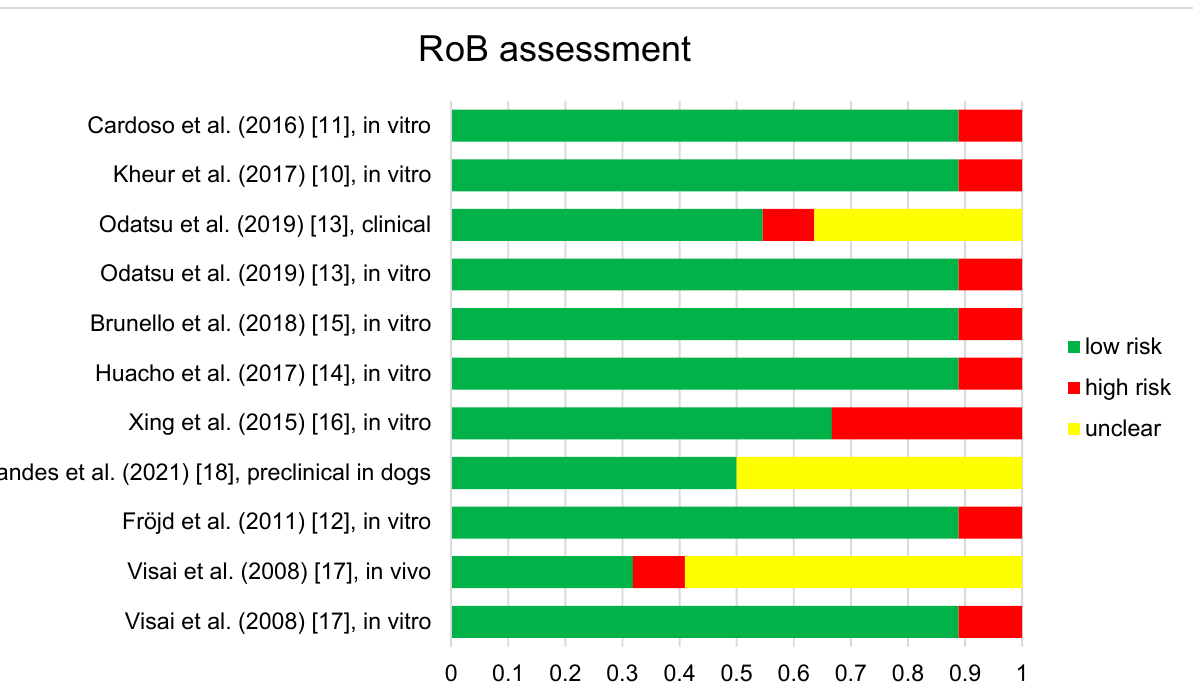
Figure 2. Results of the risk of bias assessment of the 9 studies included in this review. Studies containing different aspects, such as in vitro and clinical parts are assessed separately and displayed as such (e.g., Odatsu et al., (2019) [13], clinical and Odatsu et al., (2019), in vitro [13]), as different RoB tools were employed.